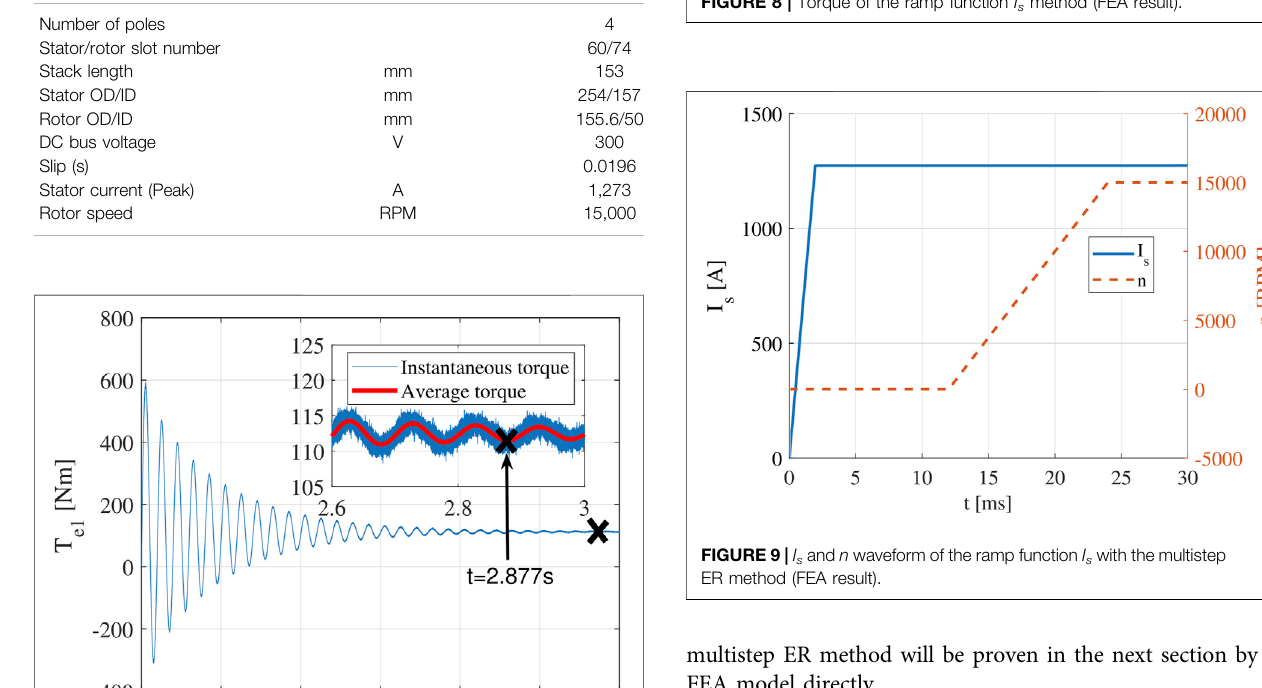
TABLE 1 | Speci fi cations of the example induction machine. Quantity